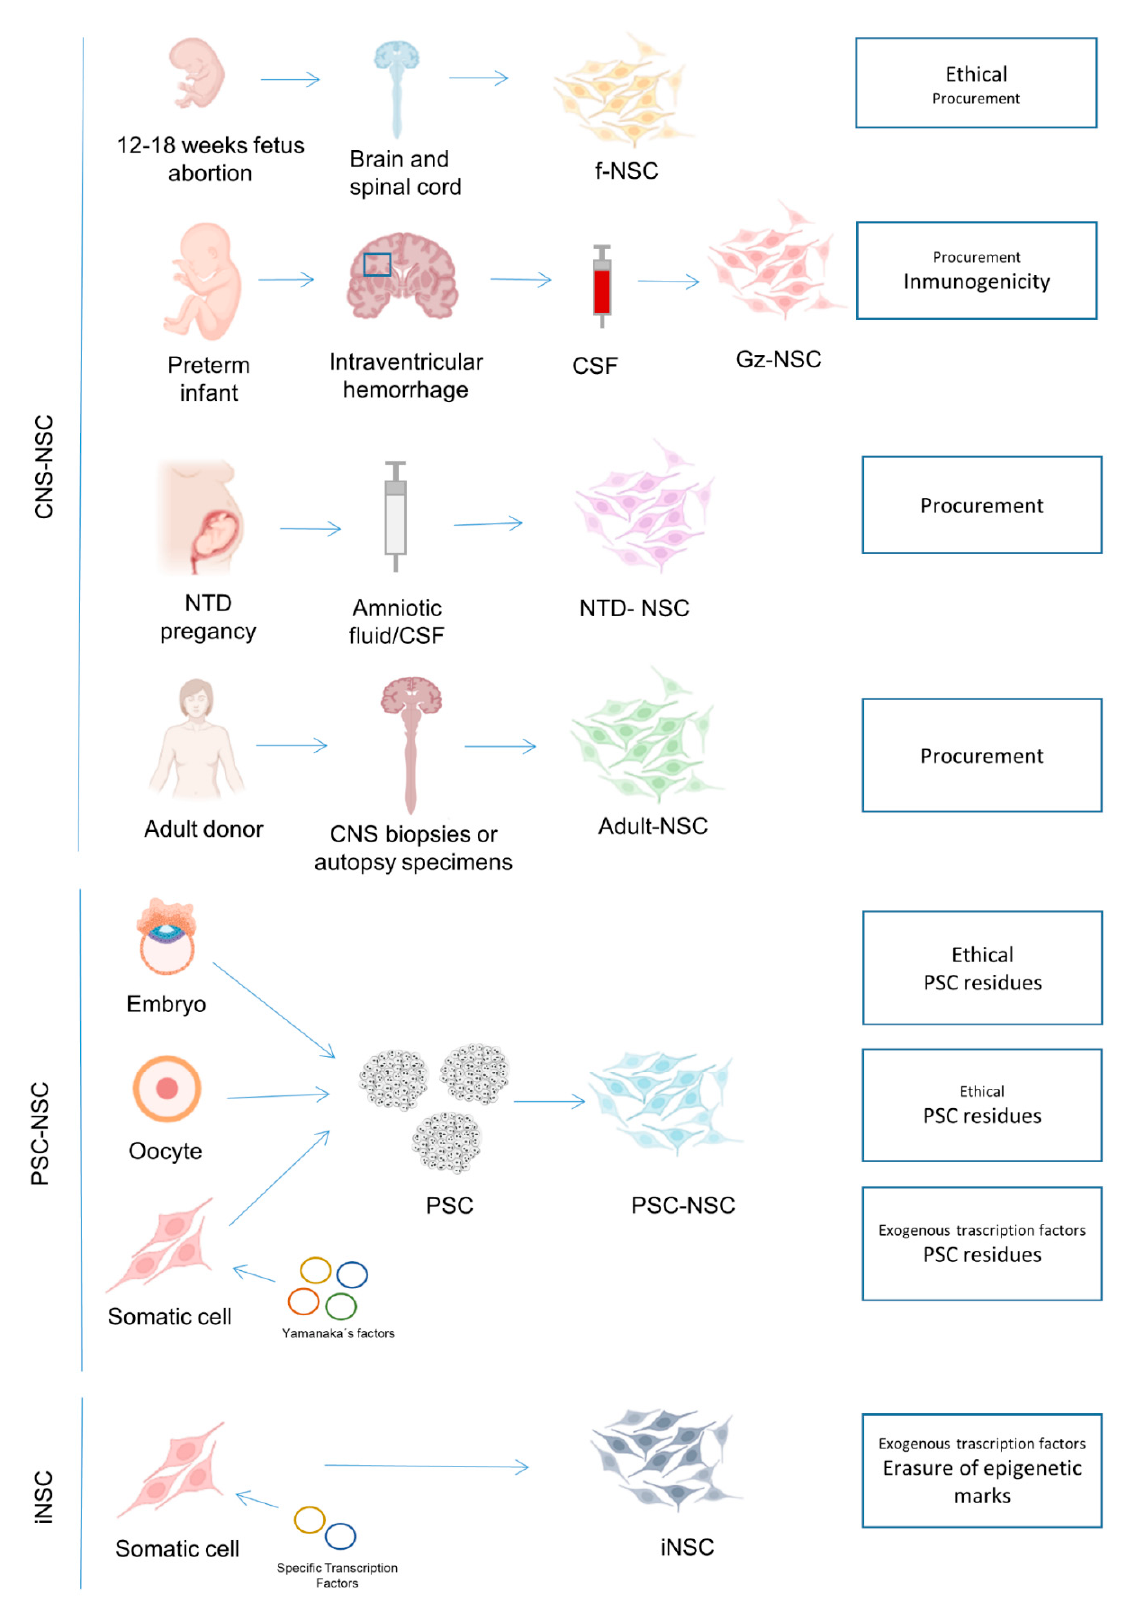
Figure 1. Available sources for NSC production and major concerns for each of them. CNS: central nervous system; PSC: pluripotent stem cells; fNSC: fetal neural stem cells, CSF: cerebrospinal fluid; Gz-NSC: germinal zone neural stem cells; NTD: neural tube defects; iPSC: induced pluripotent stem cells; ESC: embryonic stem cells; pESC: parthenogenetic stem cells; ntESC: nuclear transfer embryonic stem cells; iNSC: induced neural stem cells.